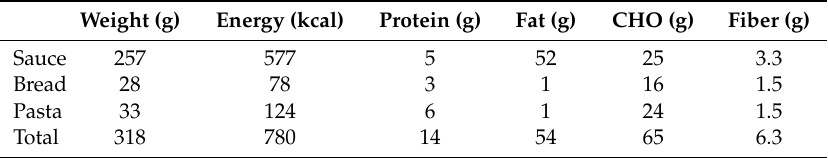
Table 1. Test fats and meal composition. Data are representative of the test meal composition for a 60 kg